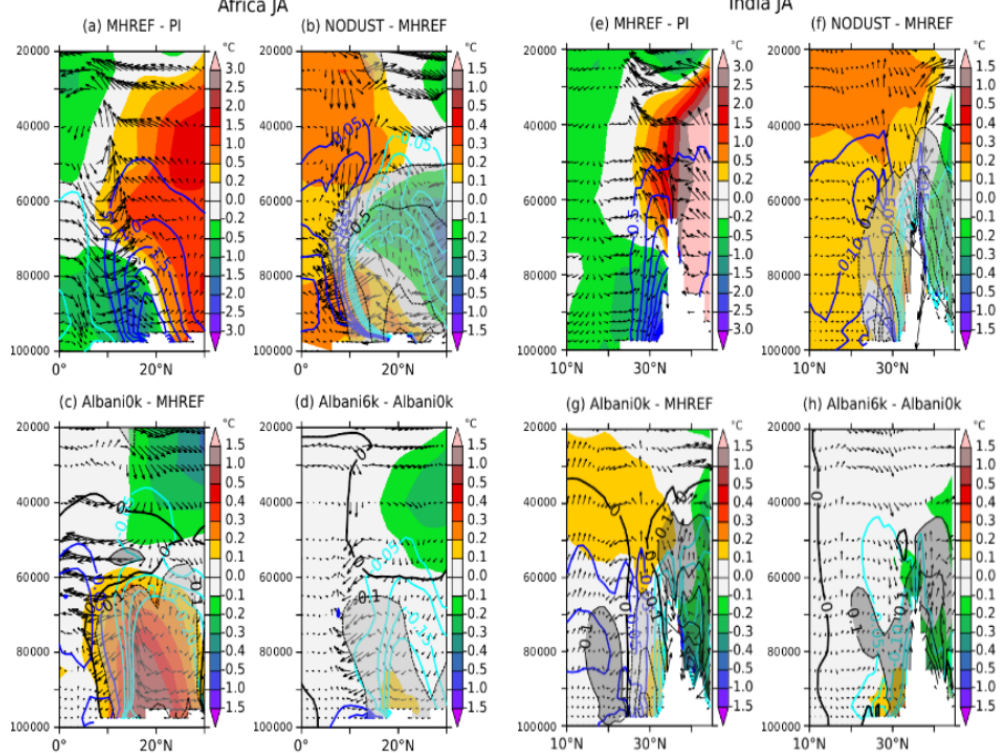
Figure 12. Zonal averages of the July–August (JA) mean atmospheric circulation over the (a–d) West African (10 ◦ W to 10 ◦ E) and (e– h) Indian (70 to 90 ◦ E) monsoon regions showing the effect of (a, e) the mid-Holocene insolation compared to the pre-industrial climate (MHREF–PI), (b, f) the effect of NODUST on the mid-Holocene climate (NODUST–MHREF), (c, g) the effect for Albani0k on the mid- Holocene climate (Albani0k–Albani6k) and (d, g) the effect of Albani6k compared to Albani0k on the mid-Holocene climate (Albani6k– Albani0k). Each plot considers the atmospheric temperature ( ◦ C, colour scale), the meridional winds (with a − 1 factor imposed on the vertical component in hPa/s to have more intuitive vision of upward and downward motions), the specific humidity (kgkg − 1 , light and dark blue contours respectively for negative and positive value) and the dust concentrations (black contours, plotted on top of light grey where the dust content is reduced and dark grey where dust content is increased). For each monsoon region the top right panel has different scales, which reflect the larger impact of the insolation forcing and no dust contour, which accounts for the fact that there is no change in dust between the mid-Holocene reference simulation and the pre-industrial